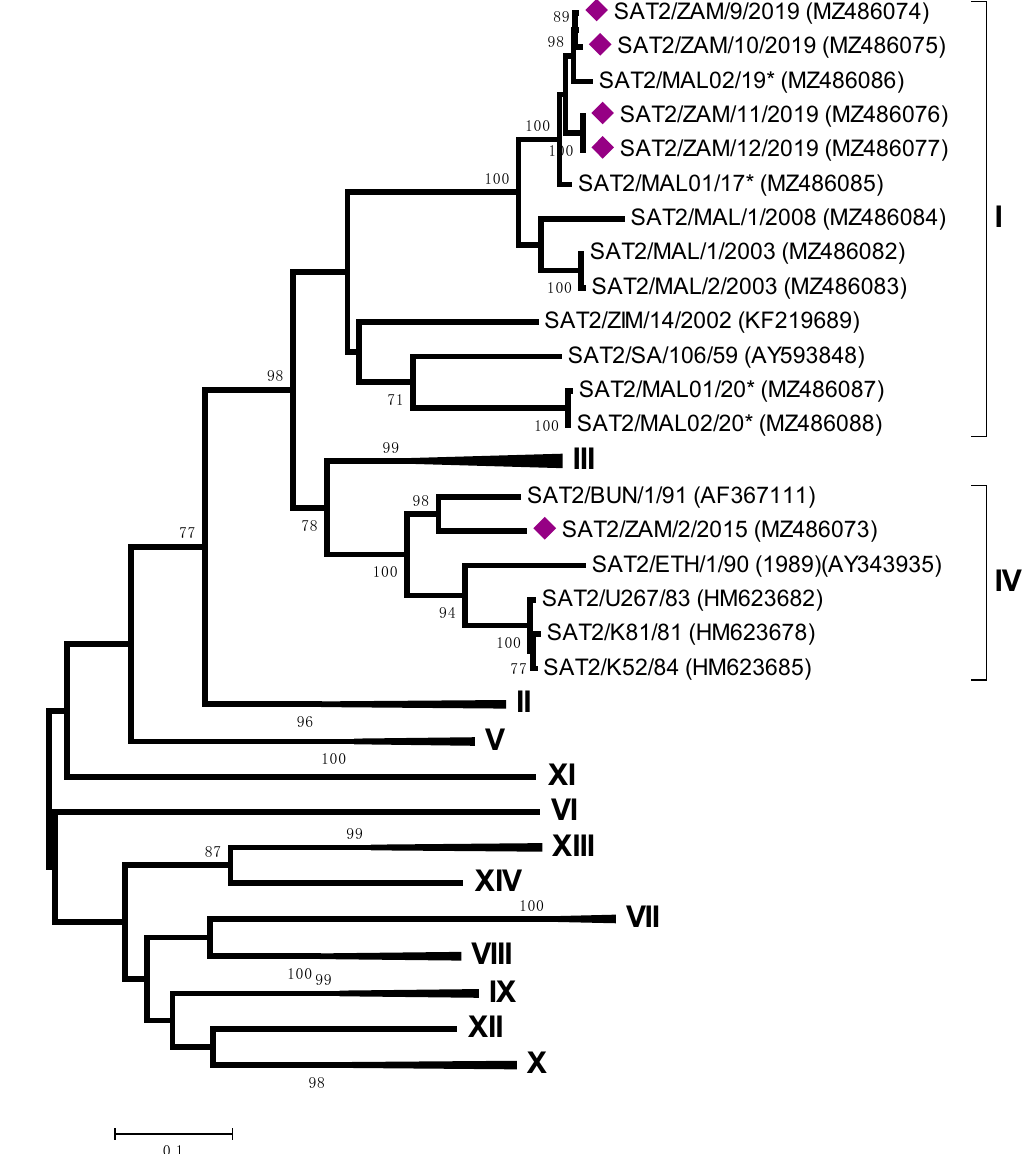
Figure 5. Midpoint-rooted maximum likelihood tree showing the relationships between the VP1 sequences of the 2015 and 2019 foot-and-mouth disease virus SAT-2 serotypes from Zambia (indicated with diamonds) and other contemporary and reference viruses. * Reference number not assigned by the WRLFMD.